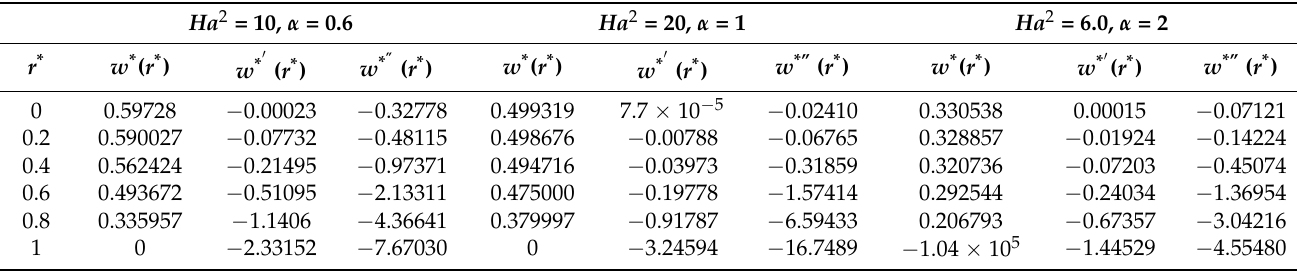
Figure 5. ( a – d ) shows the behavior of velocity profile under the influence of variations in the nonlinearity parameter for different values of Ha 2 . Table 3. The values of w ∗ ( r ∗ ) , w ∗ (cid:48) ( r ∗ ) , and w ∗ (cid:48)(cid:48) ( r ∗ ) for different variations in the Hartmann electric number and nonlin- earity